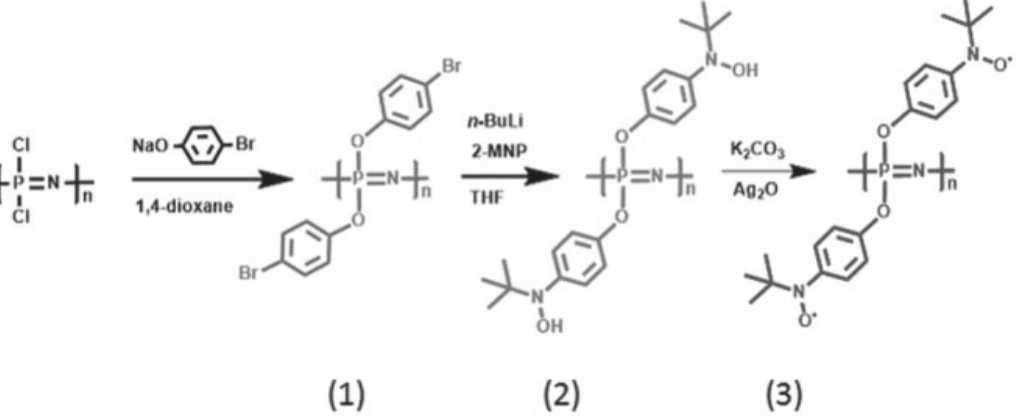
Figure 11. Synthetic pathway of polyphosphazenes (1–3). Taken with permission from [135].